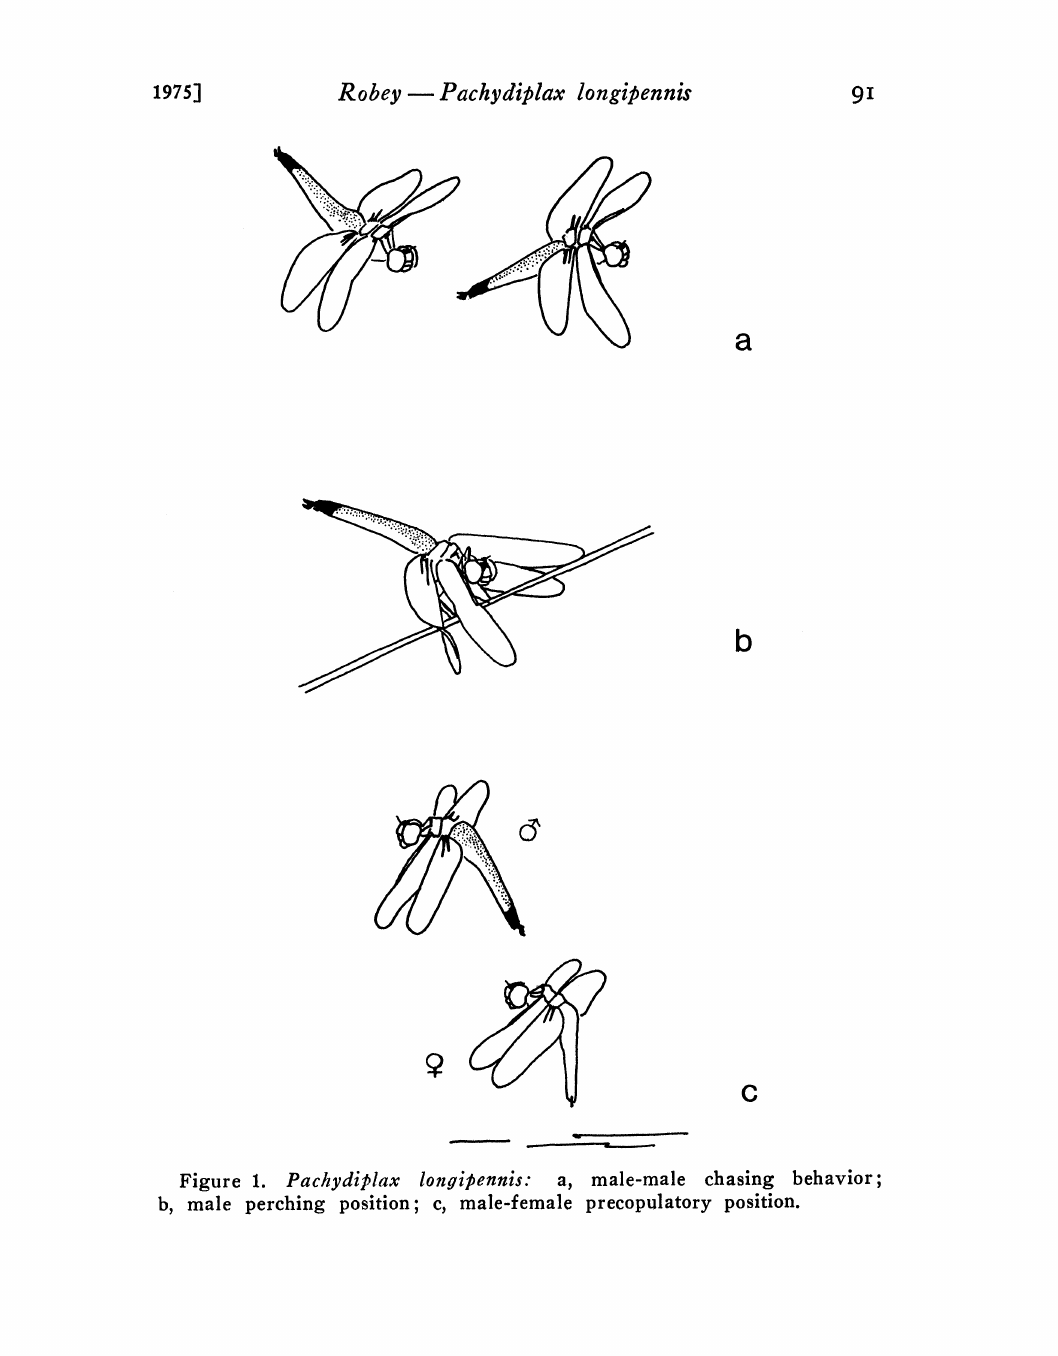
Figure 1. Pachydillax longilennis: a, male-male chasing behavior; b, male perching position; c, male-female precopulatory